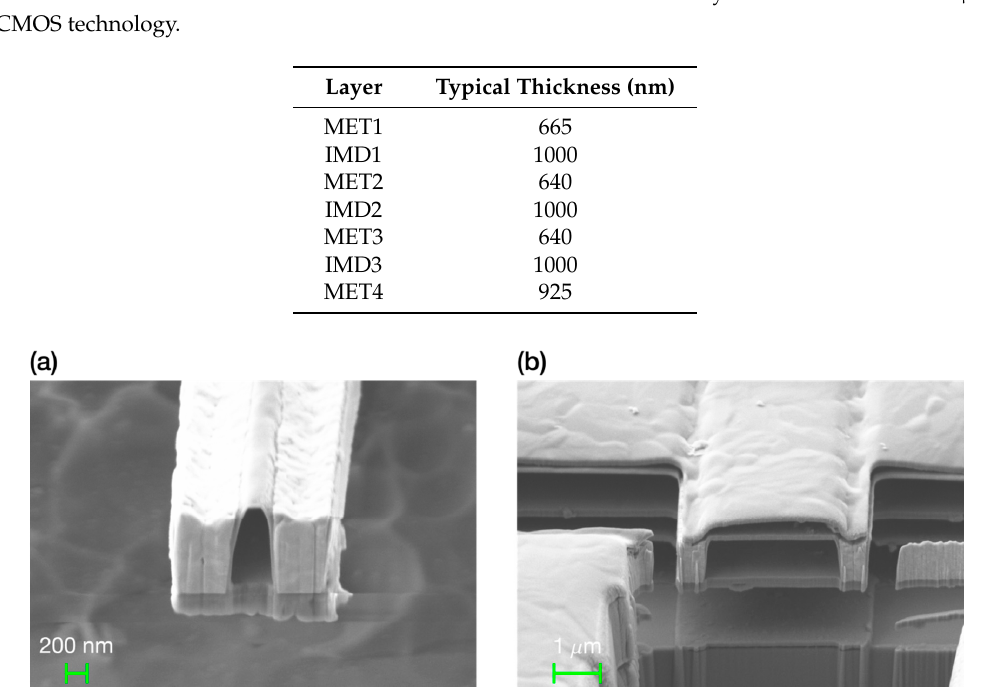
Figure 3. Scanning electron microscope (SEM) images after focused ion beam (FIB) milling showing suspended nanochannel microbridge resonators fabricated using different layers and presenting nanochannels of different widths. ( a ) MET3-VIA3-MET4 nanochannel of 450 nm width, the minimum width allowed by the technology. ( b ) MET2-VIA2-MET3 nanochannel of 3 μ m width.